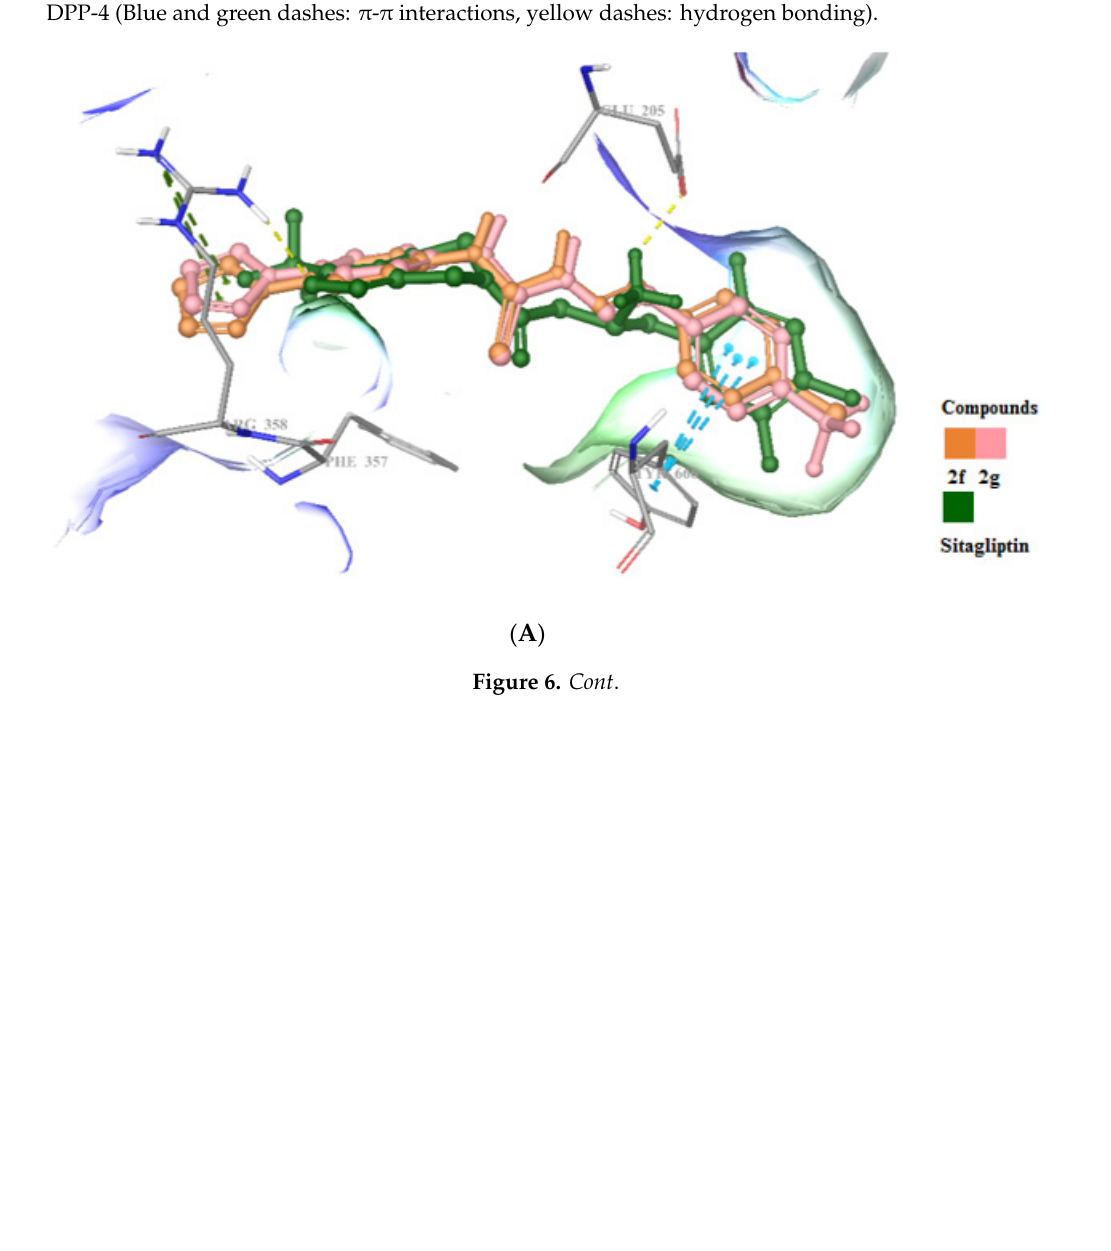
Figure 5. Docking poses of compounds 2f , 2g , 2i , 2k and 2o along with sitagliptin in the active site of DPP-4 (Blue and green dashes: π - π interactions, yellow dashes: hydrogen bonding).